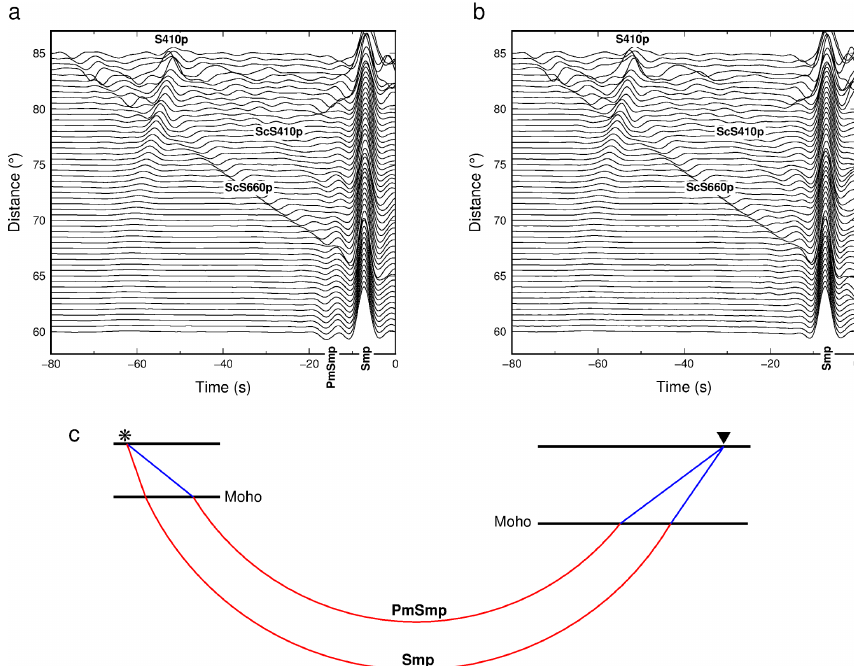
Figure 7. Theoretical seismograms for different structures at the source and receiver sides. (a) Moho is at 50km depth at the source side, (b) no crust at the source side. Moho depth is 40km at the receiver side in both cases. The source crust causes a negative precursor before the receiver side S-to-P conversion at the Moho (see PmSmp ray path in c ), which could be mistaken as an indication of a velocity drop in the mantle below the Moho. Such phases will only be a problem in interpretations of single data traces. In receiver function processing of real data this should not be a problem since source side models and source depths are different for each record and these effects are erased by summation. (c) Ray paths of Smp and